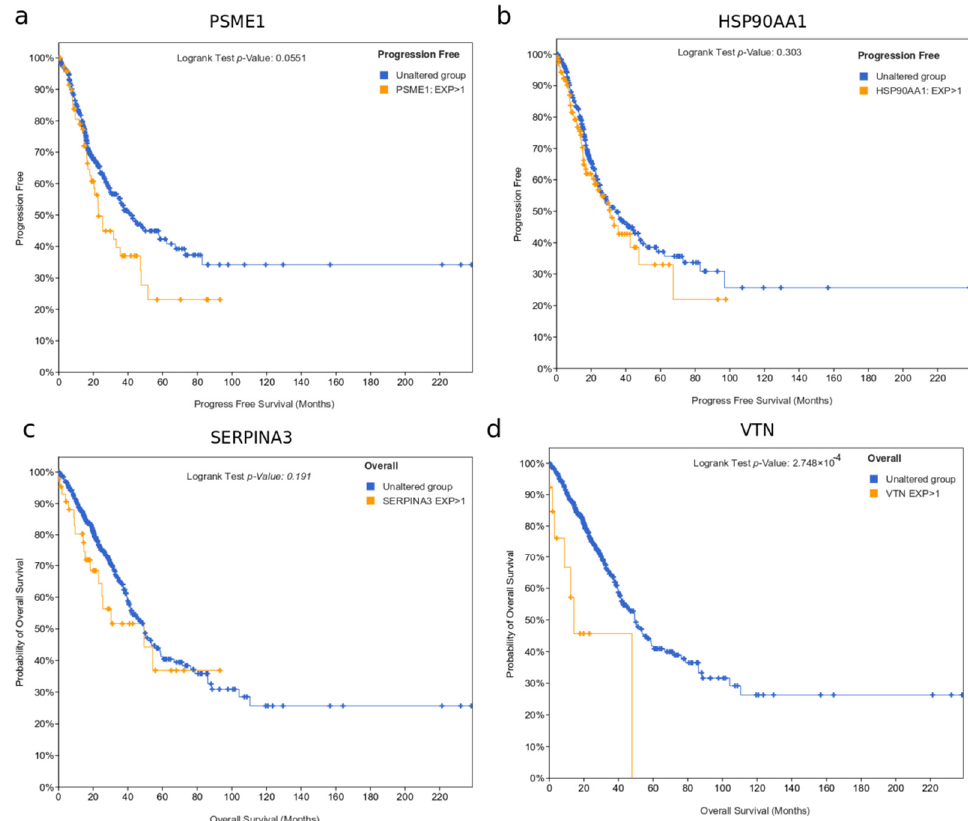
Figure A7. Comparing survival for high mRNA expression (>1 standard deviation from mean) versus expression within one standard deviation from mean for the markers ( a ) PSME1, ( b ) HSP90AA1, ( c ) SERPINA3 and ( d ) VTN.